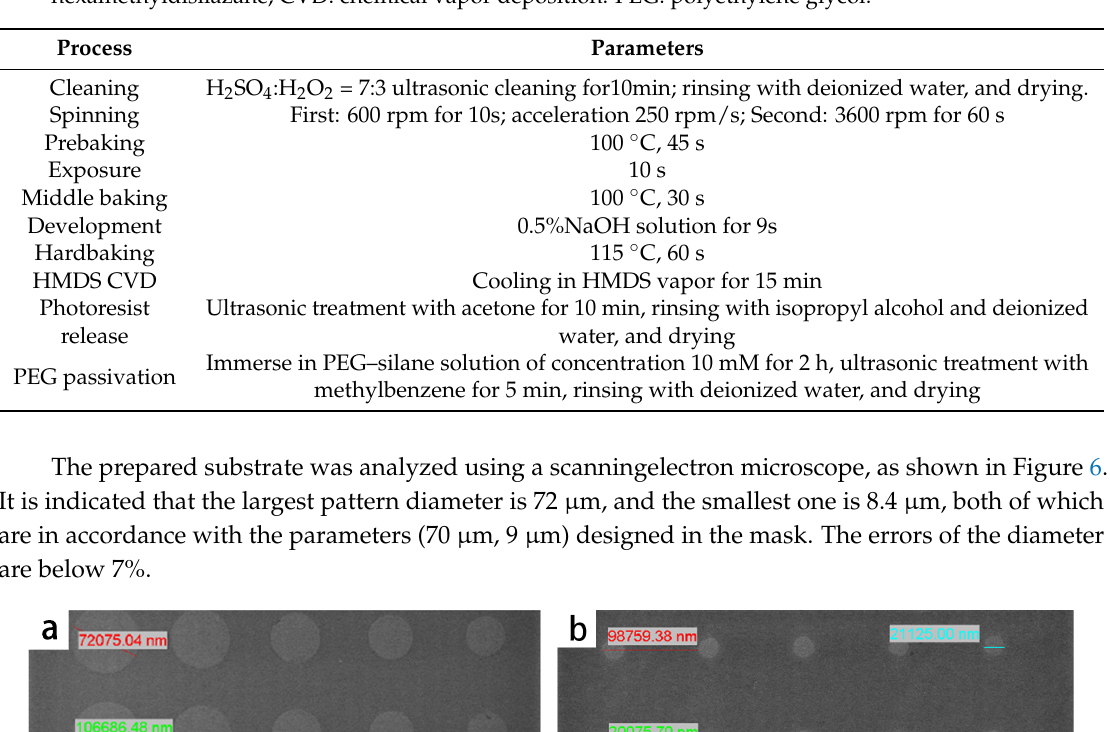
Table 1. The optimized processing parameters for the substrate of single-cell patterning. HMDS: